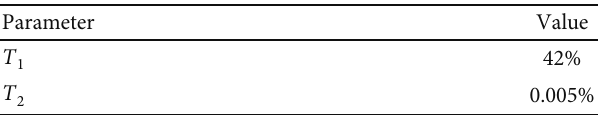
Figure 9: Simulink setup of the proposed enhanced P&O MPPT method. Table 5: Parameters of the enhanced P&O